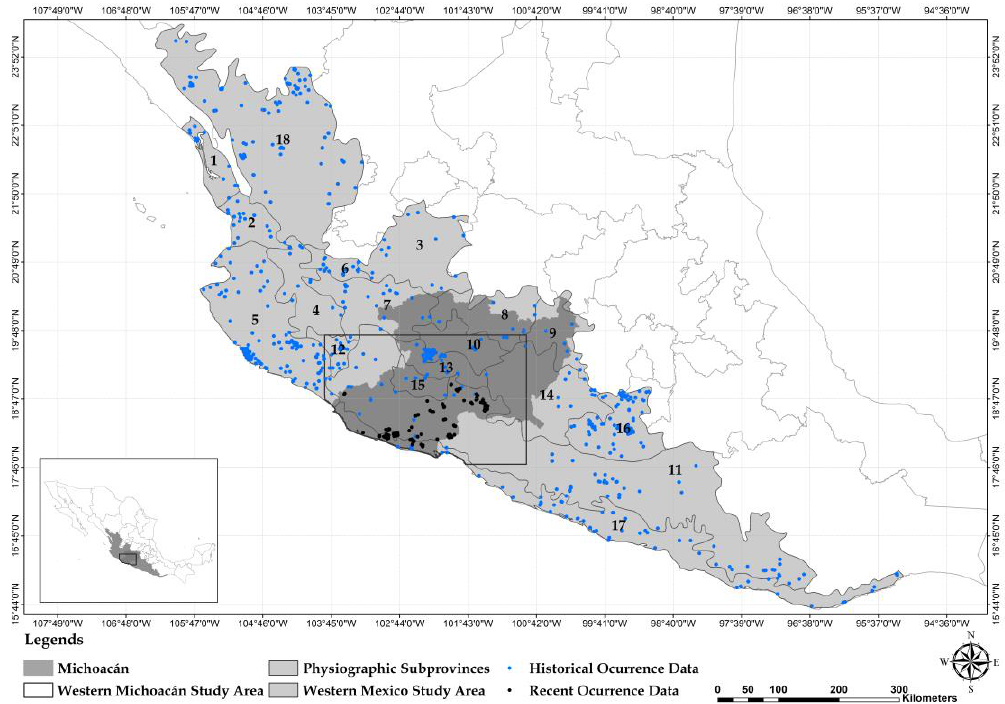
Figure 1. Study areas’ location, physiographic provinces (see Table A1) and records of 11 carnivore species distributed in western México. (1) Delta del Río Grande de Santiago , (2) Sierras Neovolcánicas Nayaritas , (3) Altos de Jalisco , (4) Sierra de Jalisco , (5) Sierras de la Costa de Jalisco y Colima , (6) Guadalajara , (7) Chapala , (8) Sierras y Bajíos Michoacanos , (9) Mil Cumbres , (10) Neovolcánica Tarasca , (11) Cordillera Costera del Sur , (12) Volcanes de Colima , (13) Escarpa Limítrofe del Sur , (14) Depresión del Balsas , (15) Depresión de Tepalcatepec , (16) Sierras y Valles Guerrerenses , (17) Costas del Sur , and (18) Mesetas y Cañadas del Sur. Historical data are species occurrence records obtained from public collections, while recent occurrence data are records obtained from field sampling in western Michoacán.